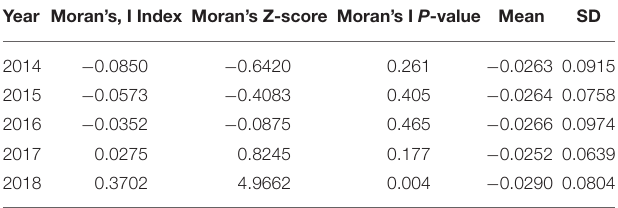
TABLE 3 | Global spatial autocorrelation of influenza in